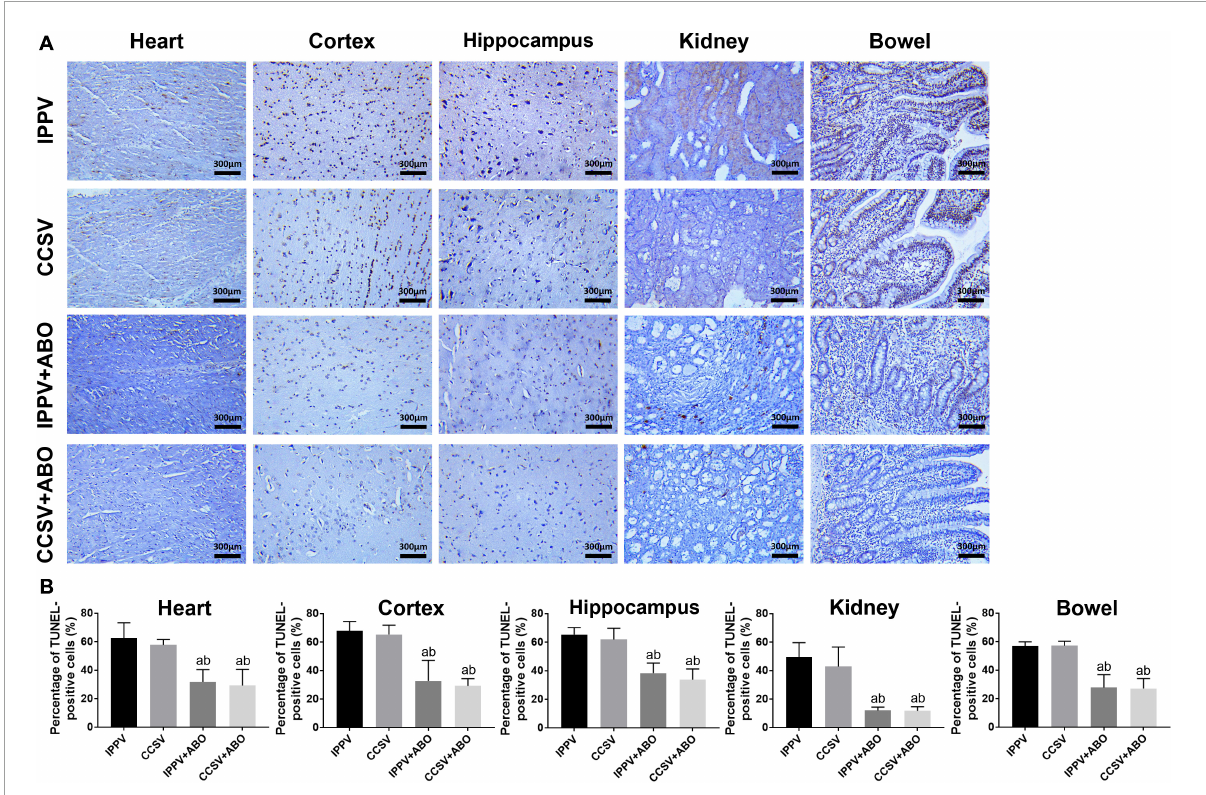
FIGURE5 The evaluation of pathological damage in the heart, cortex, hippocampus, kidney, and intestine at 24 h post-resuscitation among the four groups. (A) Representative photomicrographs of terminal deoxynucleotidyl transferase dUTP nick-end labeling (TUNEL) assay (200 × magnification). (B) The percentage of TUNEL-positive cells. IPPV, intermittent positive pressure ventilation; CCSV, chest compression synchronized ventilation; ABO, aortic balloon occlusion. Tissue samples were obtained at 24 h post-resuscitation, in which each group contained 4–6 swine. a P < 0.05 for CCSV + ABO group, IPPV + ABO group vs. IPPV group; b P < 0.05 for CCSV + ABO group, IPPV + ABO group vs. CCSV